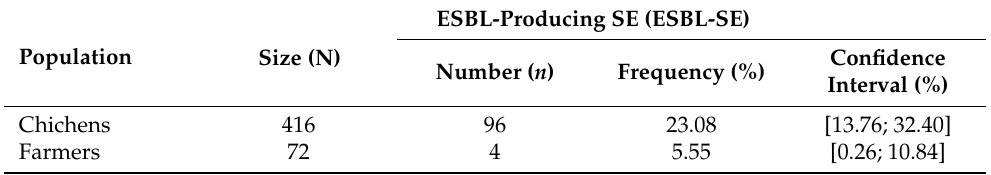
Table 3. Distribution of ESBL in the studied